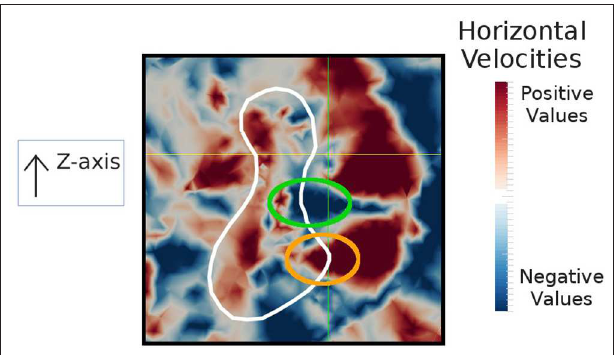
FIGURE 10 | 2D cut-view of the firn material showing the surface-diffusion velocity field in the horizontal direction. Blue colors stand for negative values and red colors for positive values. The interface of a pore is highlighted in white in the middle of the section. The green and orange circles, respectively, show the regions where the interface is receding in the ice phase and growing in the pore phase. This leads to the rounding of the pore.